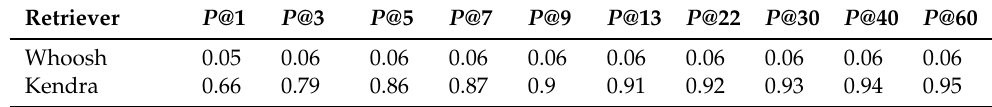
Table 3. Retrievers’